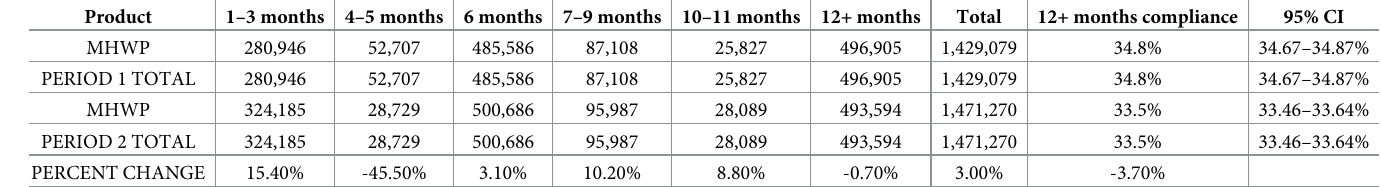
Table 10. Patient level comparison of doses purchased Period 1 vs Period 2. Non-PH users.